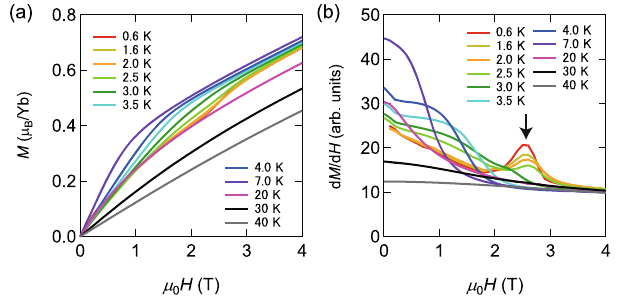
Fig. 3 Phase boundary determined by magnetization measurements. a Field dependence of the magnetization M of crystal #3 for H ∥ c . b Field dependence of d M /d H . Peak indicated by the arrow corresponds to the boundary between AF-I and AF-II